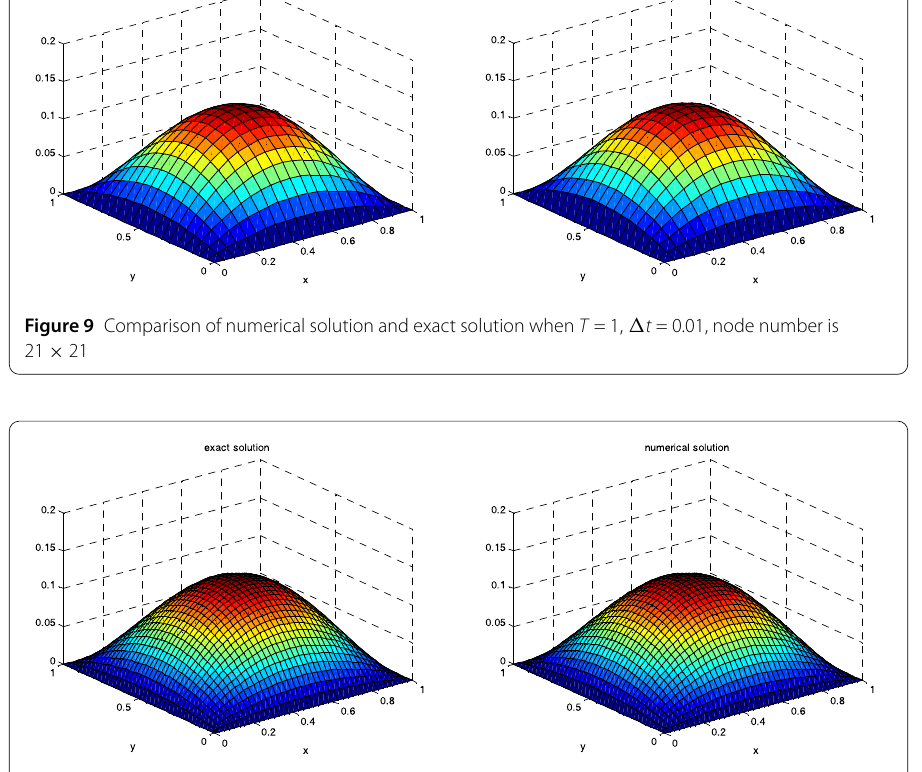
Figure 10 Comparison of numerical solution and exact solution when T = 1, (cid:11) t = 0.001, node number is 41 ×